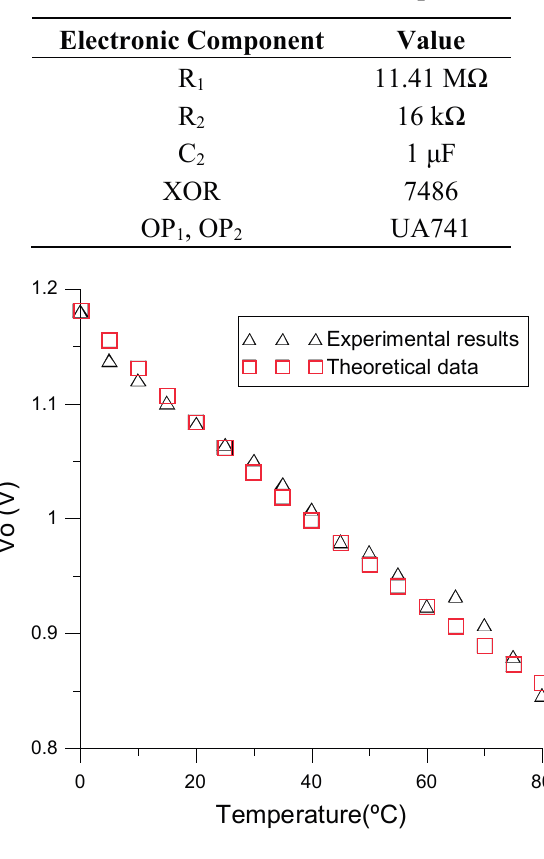
Figure 12. Experimental and theoretical output voltage under different